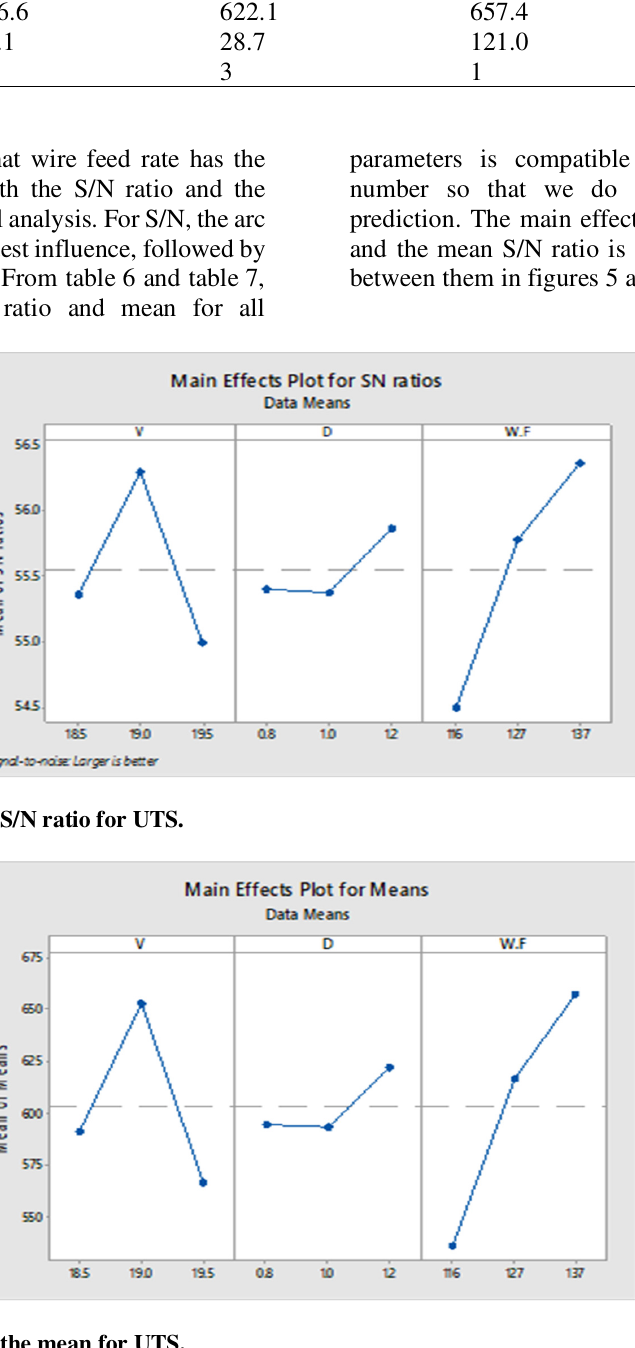
Fig. 7. Main effect plot of the mean for